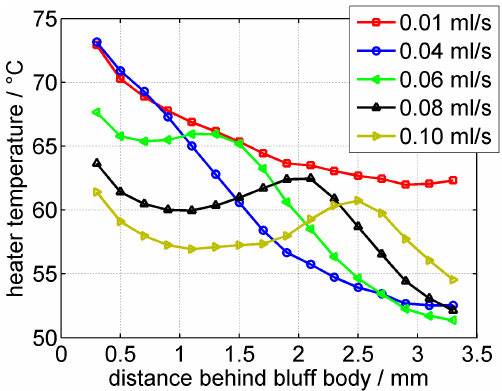
Figure 12. Simulated local temperature increase of individual heaters located at different positions behind the bluff body for 5 and 10% methanol in water, respectively, for a constant flow rate of 0.08mLs − 1 .